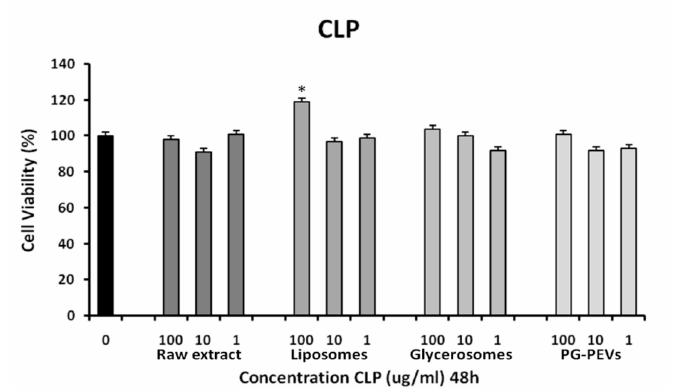
Figure 2. MTT assay after 48 h exposure to di ff erent concentrations (100, 10, 1 µ g / mL) of CLP essential oil, TC liposomes, TC glycerosomes, and TC PG-PEVs. ANOVA analysis showed high significance values (* p < 0.001) for liposomes at 100 µ g / mL vs. the untreated control (0; 100% viability).